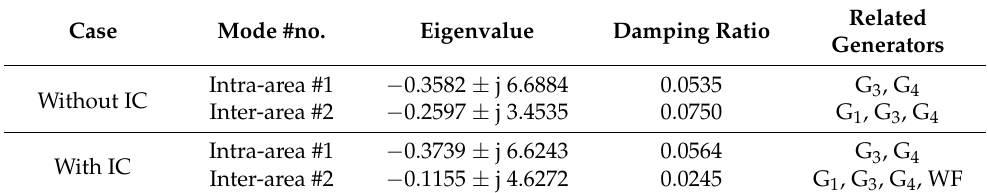
Related Generators